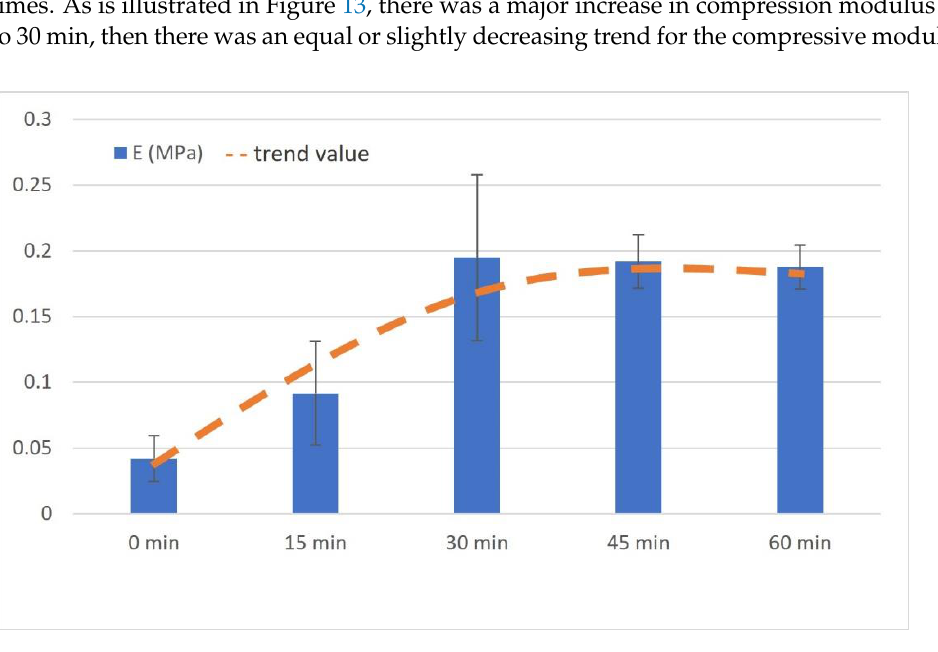
Figure 13. Compressive elastic modulus of samples with different gelling times. Bars show the mean value with SD, and the dashed line represents the trending value.